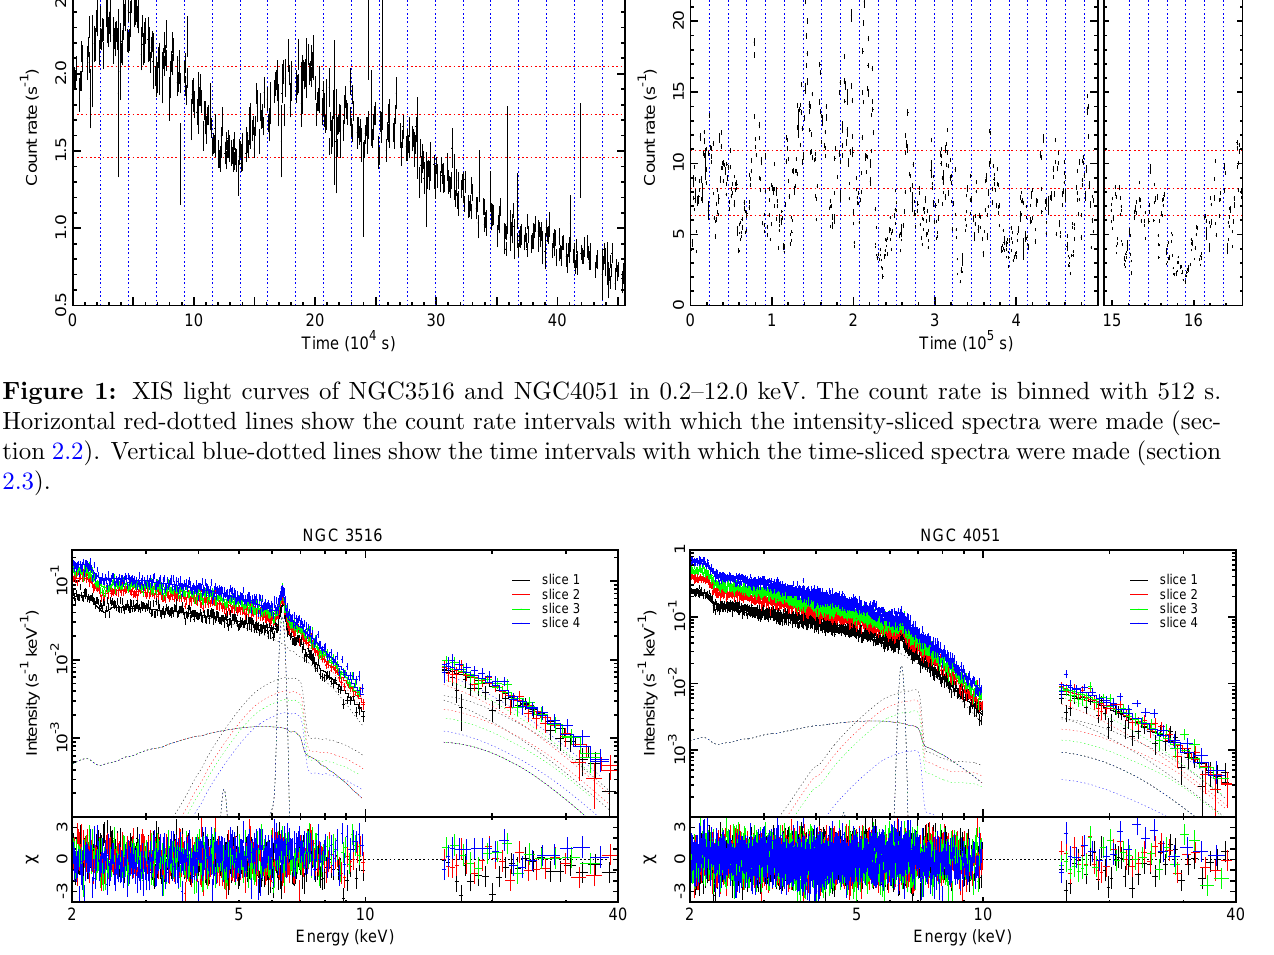
Figure 2: Model fitting results of the intensity-sliced XIS and PIN spectra for NGC3516 and NGC4051. For each observation, the four intensity-sliced spectra are made with approximately equal counts, and the four spec- tra are fitted simultaneously only varying the partial covering fraction, α . The data and the best-fit power-law model are in the upper panel, while the residuals are in the lower